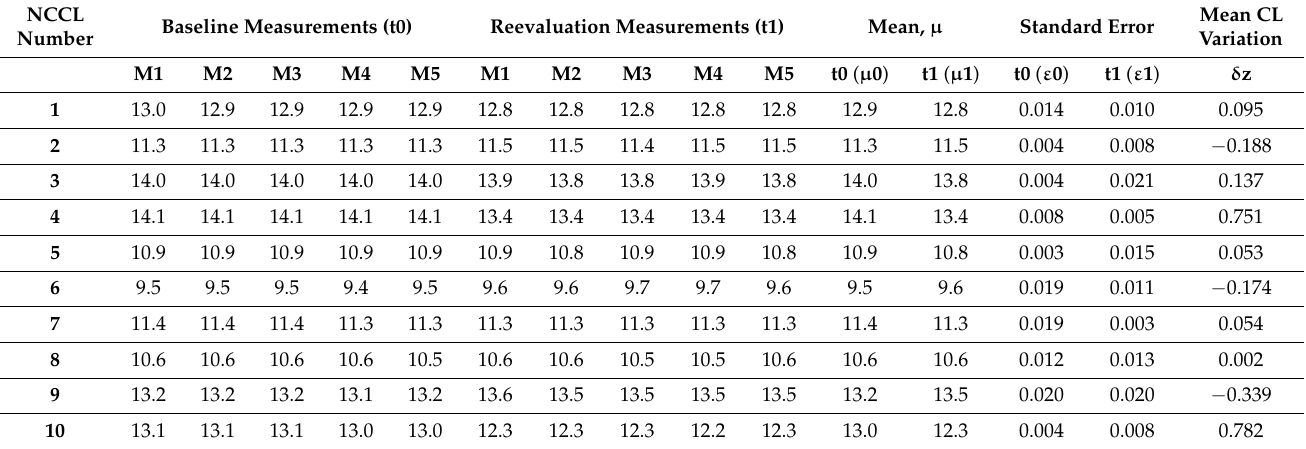
Table 1. Descriptive statistics of crown lengths (CL).